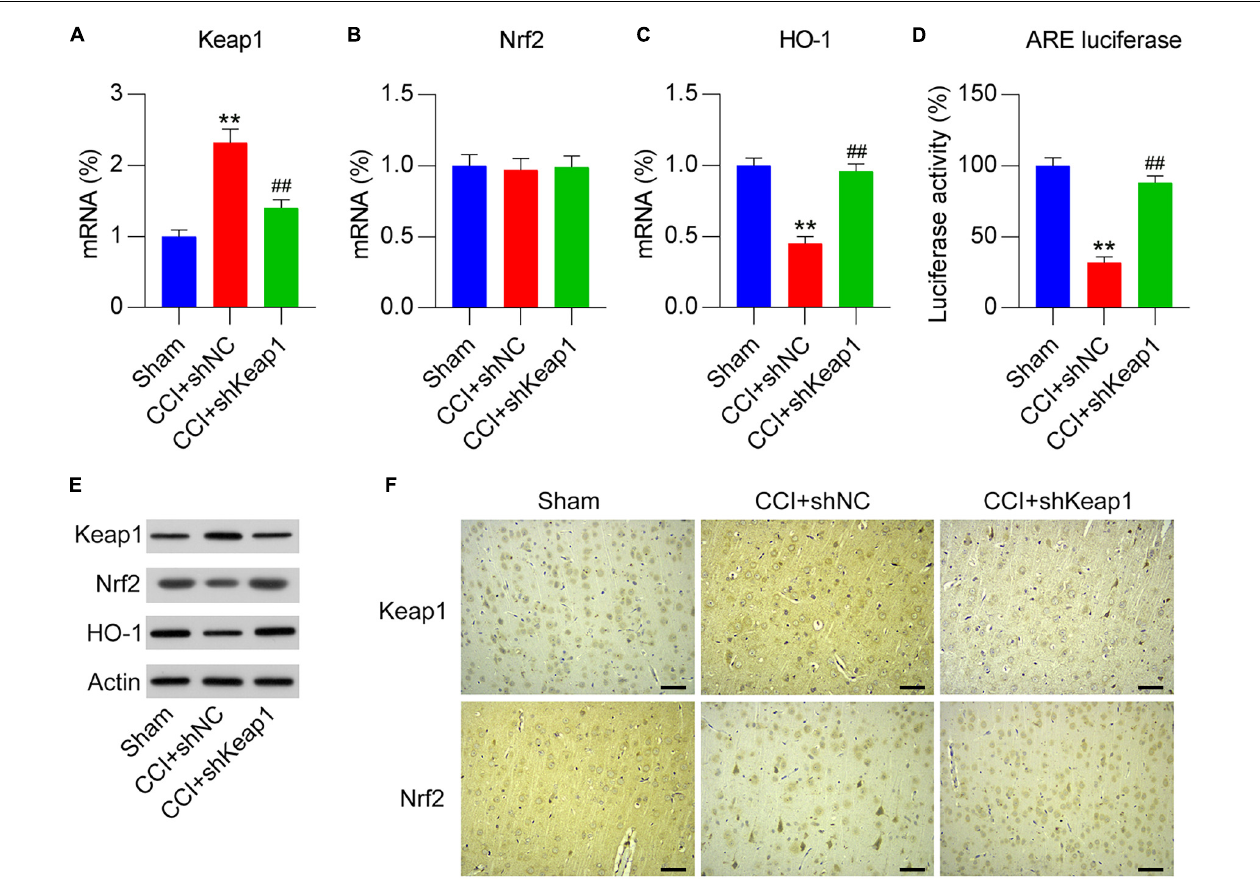
FIGURE 7 | Keap1 knockdown in CCI-induced rats intrathecally injected with lentiviral-shNC or lentiviral-shKeap1 for 1 week. Rats were then subjected to CCI surgery. (A,B) Expression levels of Keap1 and Nrf2 in the spinal cord were measured using qPCR. (C) mRNA expression level of HO-1 in the spinal cord was assayed using qPCR. (D) Isolated microglia were transfected with ARE luciferase vector, and luciferase activity was measured at 36 h after transfection. (E) Protein expression levels of Keap1, Nrf2, and HO-1 were determined using western blotting. (F) Immunohistochemical staining for Keap1 and Nrf2 expression. Scale bar, 50 µ m. ** P < 0.01 vs. Sham group; ## P < 0.01 vs. CCI + shNC